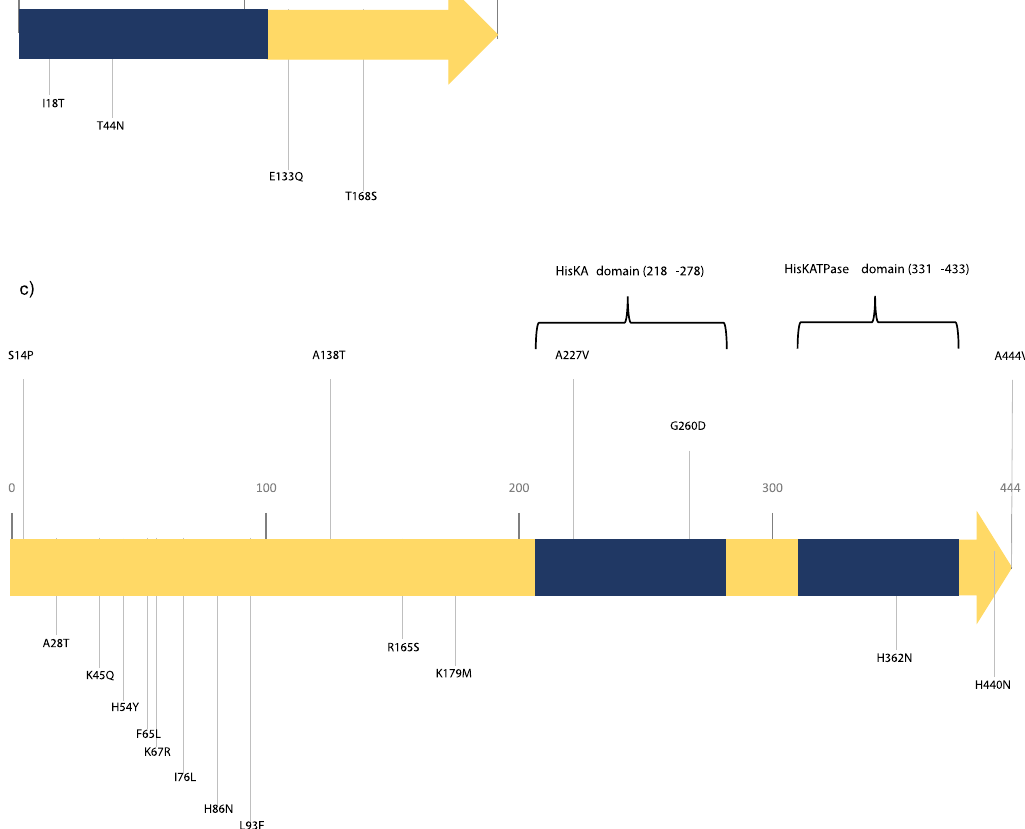
Figure 1. The amino acid substitution in PmrC ( a ), PmrA ( b ), and PmrB ( c ) amino acid sequences of colistin- resistant A. baumannii (CoR-AB) clinical isolates (n =